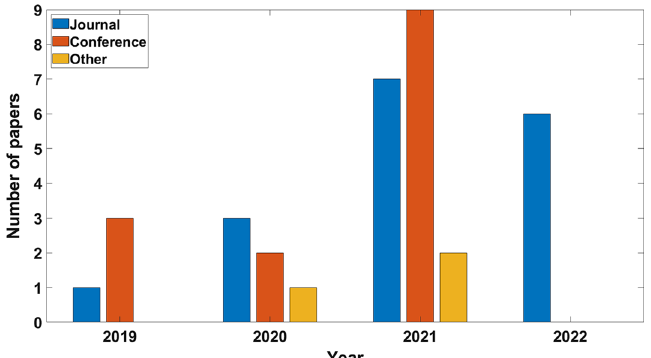
Fig. 1 Number of papers referring to DL applications in CF